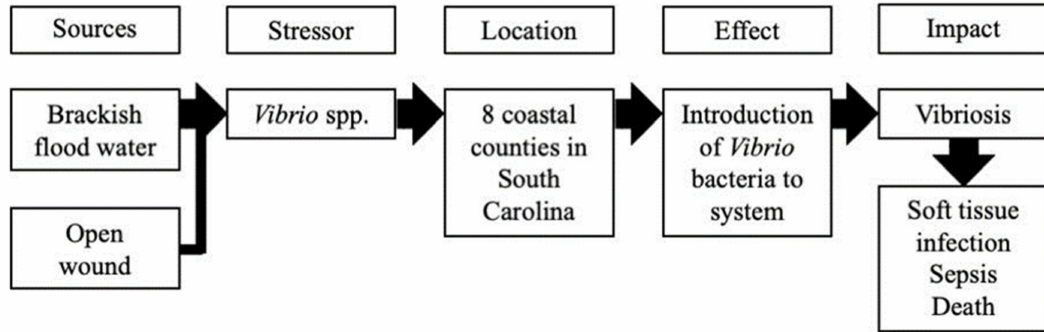
Figure 2. Conceptual model paralleling the relative risk model components (source, stressor, location, effect, and impact) and the pathway between the source of Vibrio spp. and vulnerable exposure conditions and production of Vibriosis